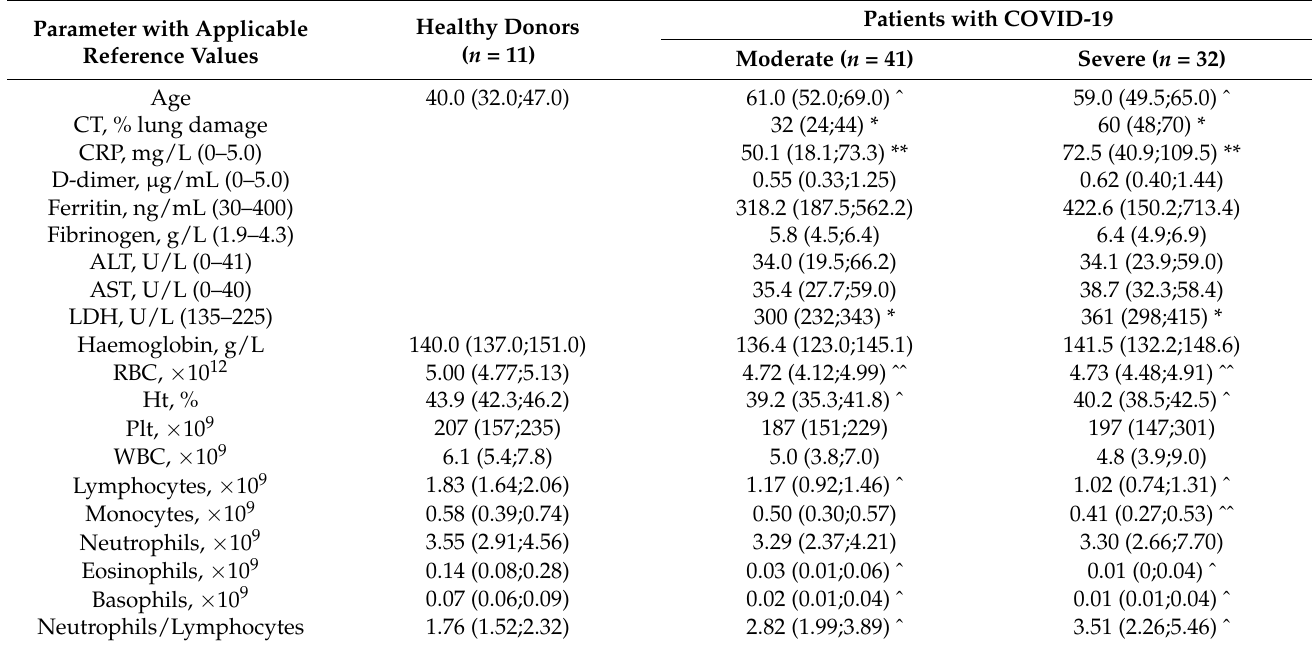
Table 2. Characteristics of healthy donors and patients with COVID-19, Me